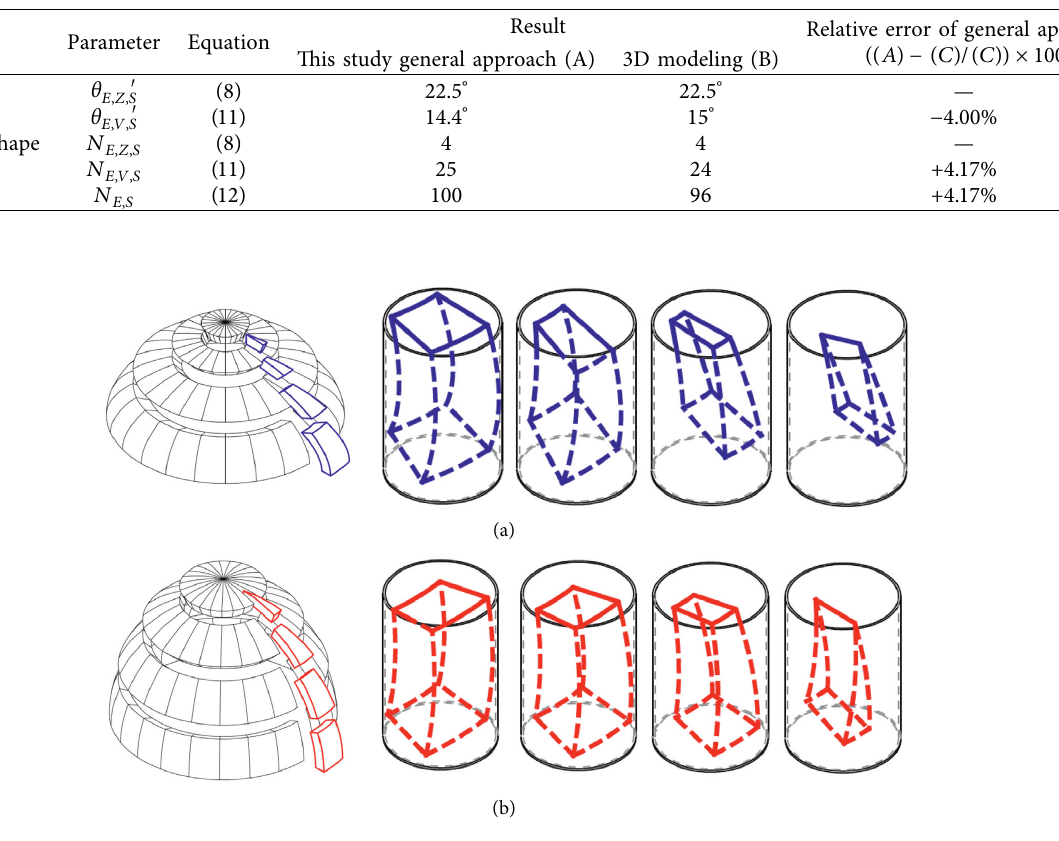
Figure 12: Results of 3D modeling using Rhino for emplacement of all types of segmented pieces into a 200 L container for (a) actual ellipsoidal-type bottom head of VVER 1000 RPV and (b) hypothetical hemispherical model assumed to apply the generalized approach to the ellipsoidal-type